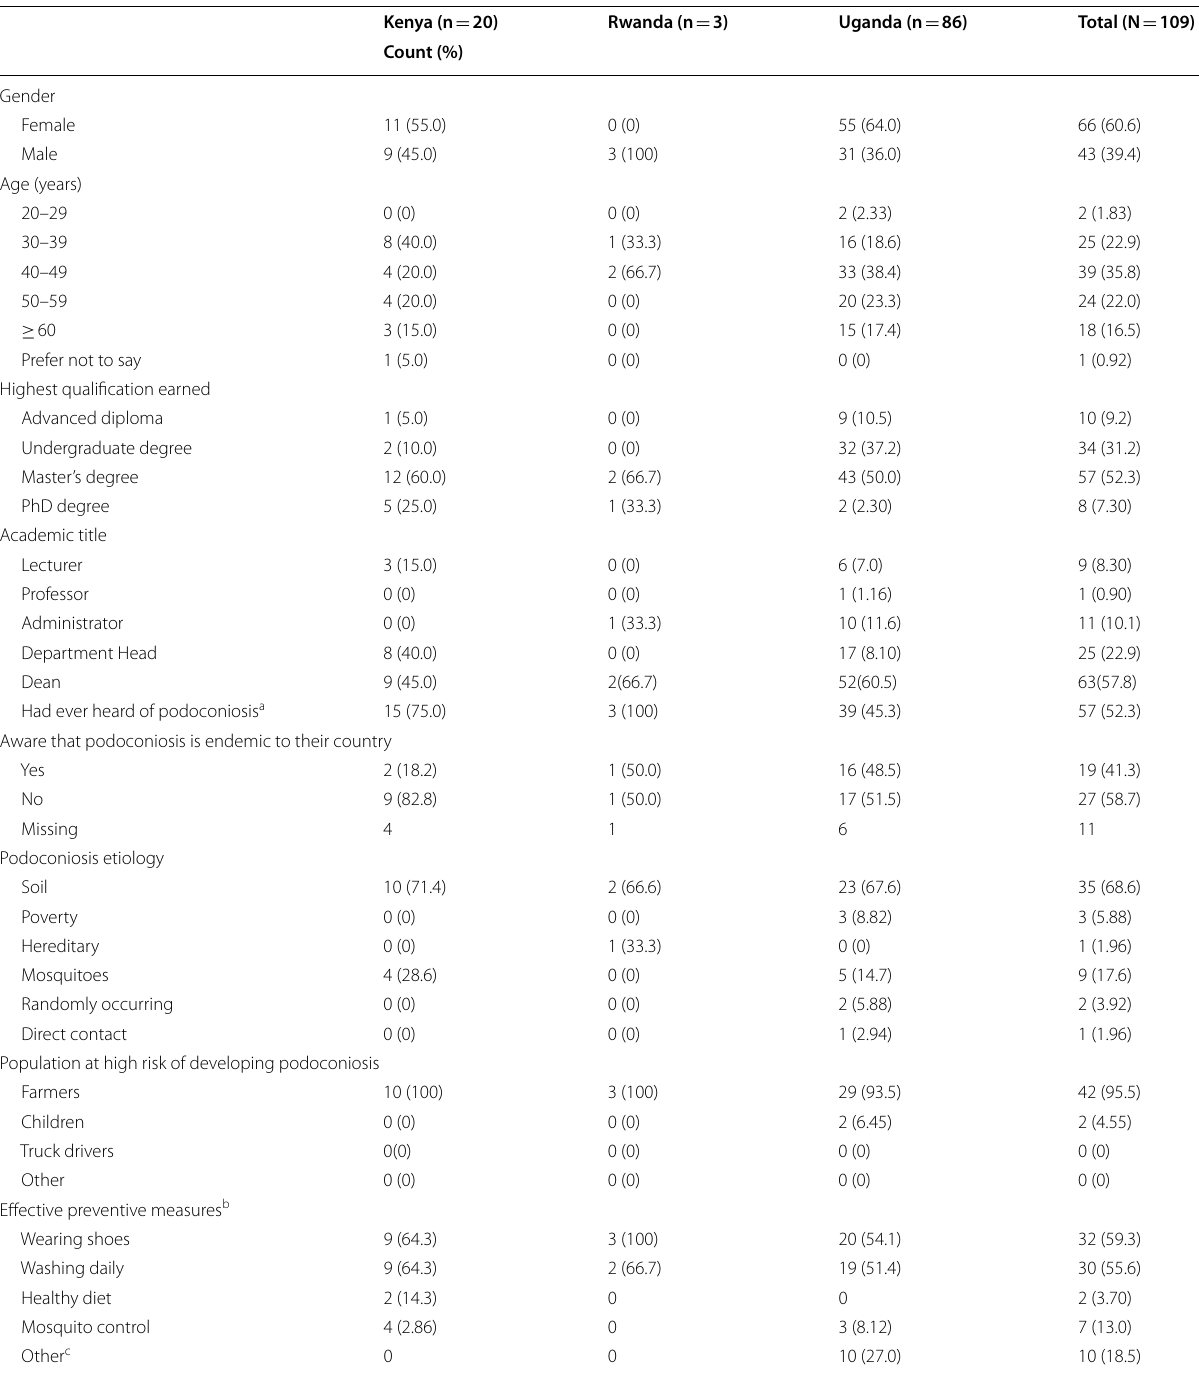
Table 2 Respondent demographics and podoconiosis knowledge (N